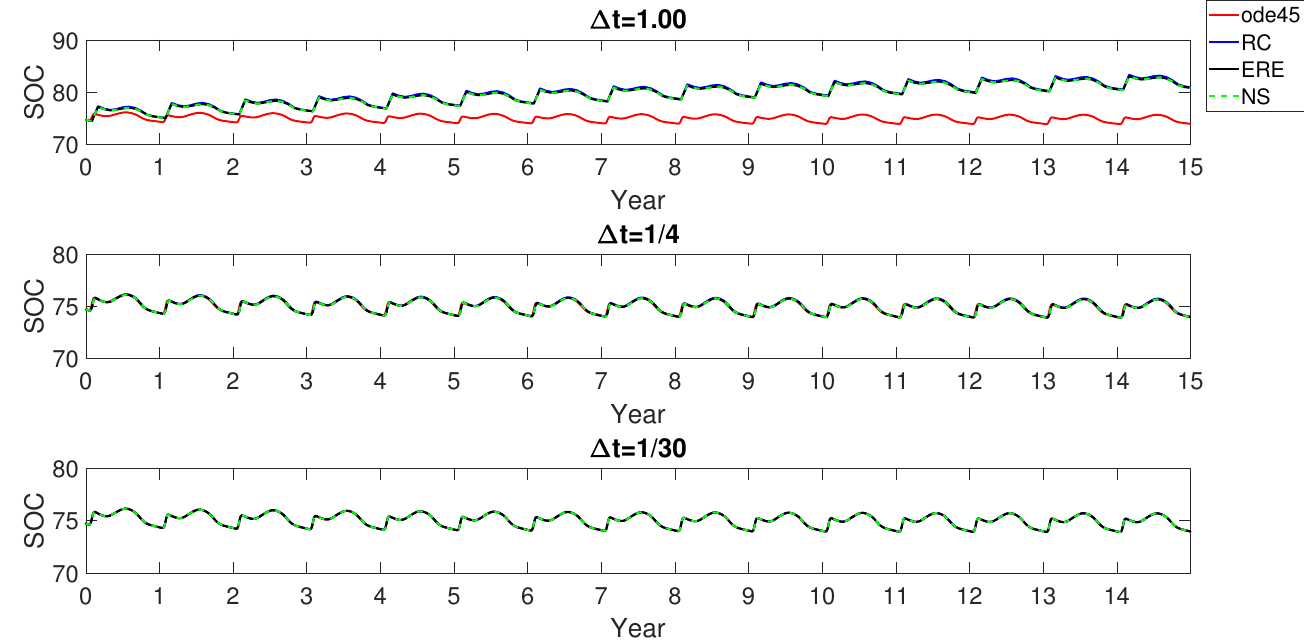
Figure 5. Long-term simulation of the SOC indicator over 15 years with the discrete RothC, ERE and NS methods. Stepsizes are set as ∆ t = 1 (1 month), ∆ t = 1/4 (1 week) and ∆ t = 1/30 (1 day). The reference solution obtained by ode45 with tolerance at the machine precision is also